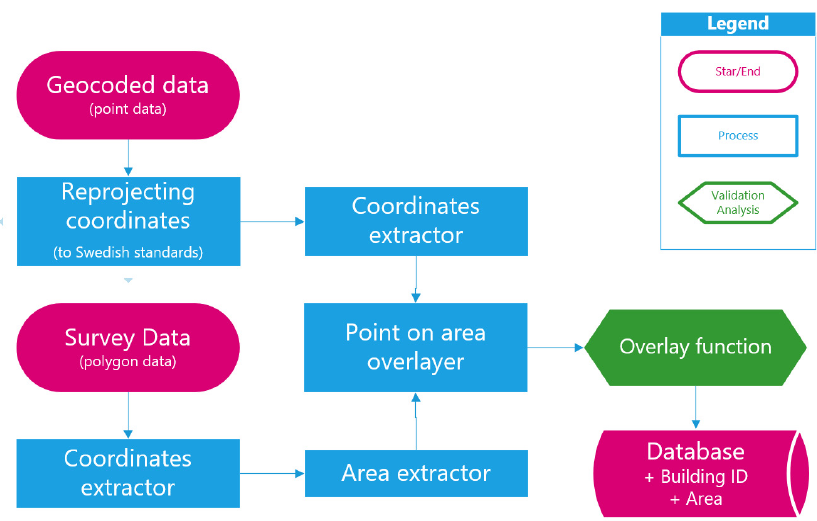
Figure 10. Area merger workflow. Figure 10.